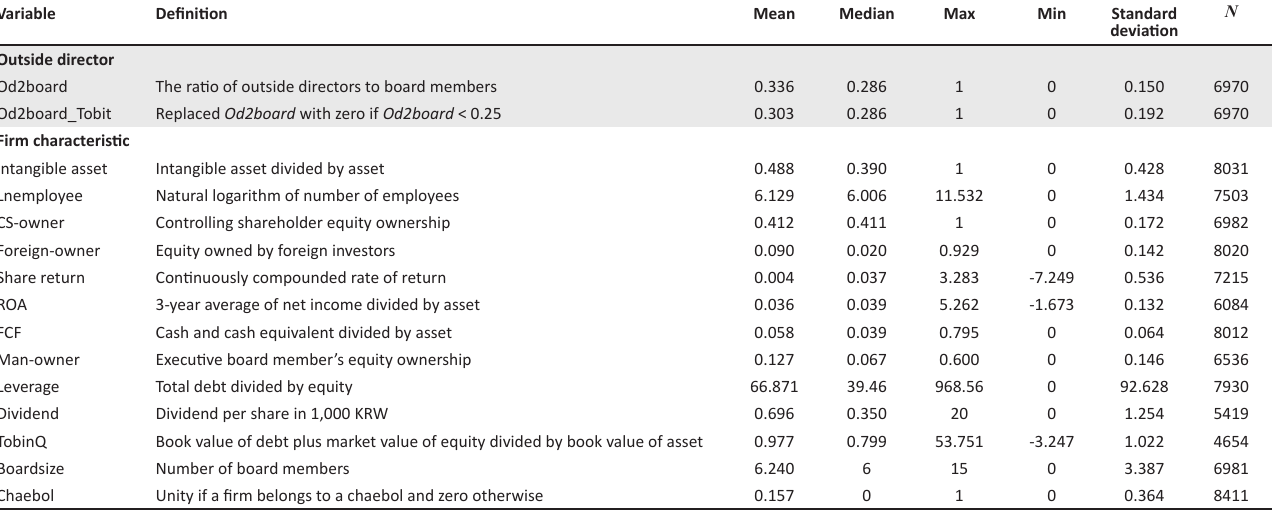
TABLE 1: Variable definitions and summary statistics.